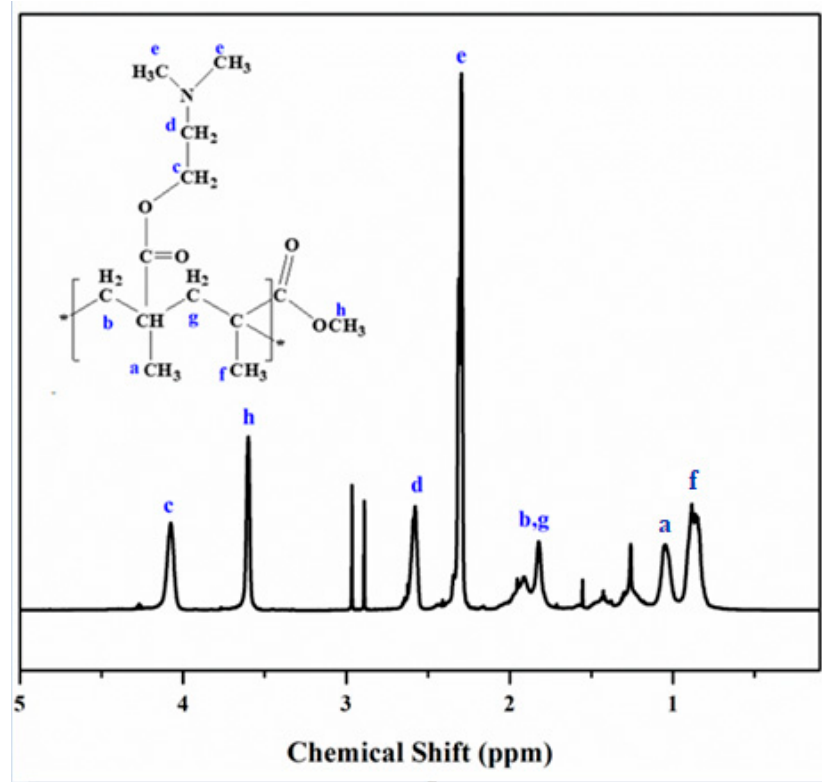
Figure 5. 1 HNMR spectrum of PDM1, P(DMAEMA- co -MMA) copolymer.